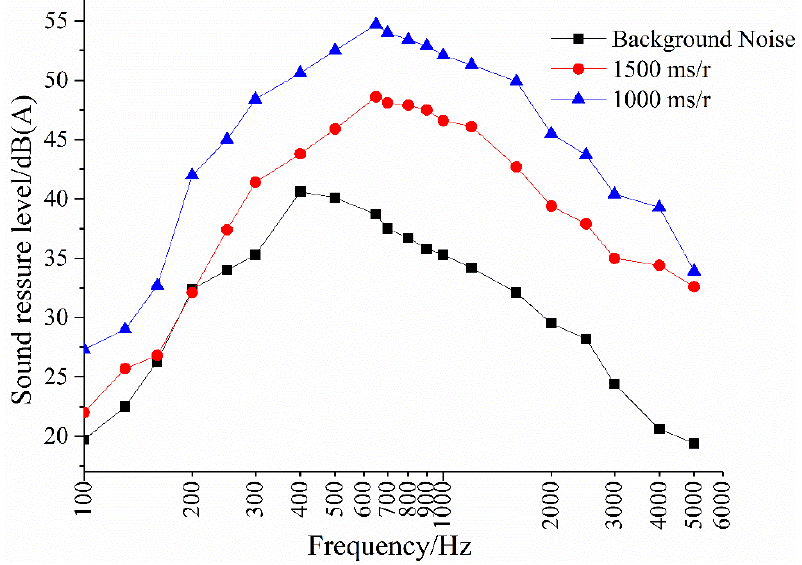
Figure 7. A pavement noise spectrogram at different driving speeds.